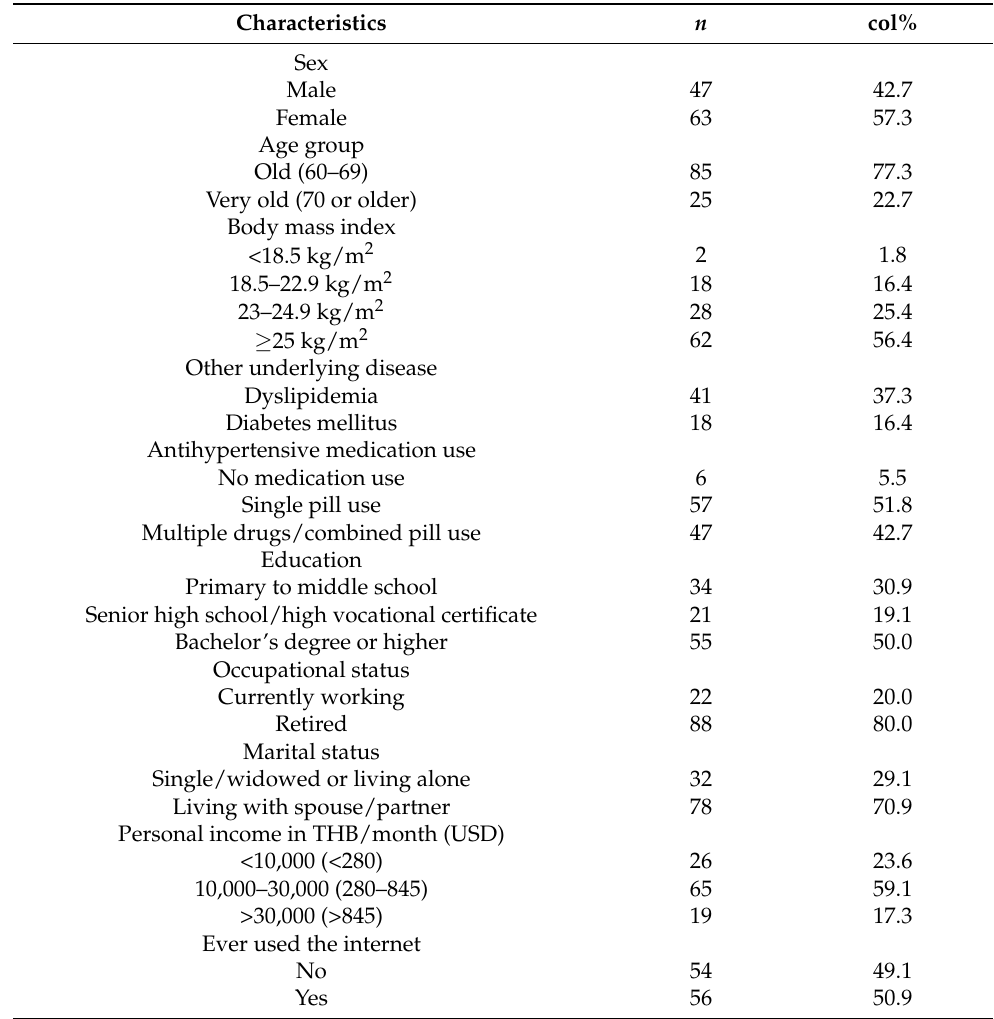
Table 1. Sociodemographic characteristics ( n =